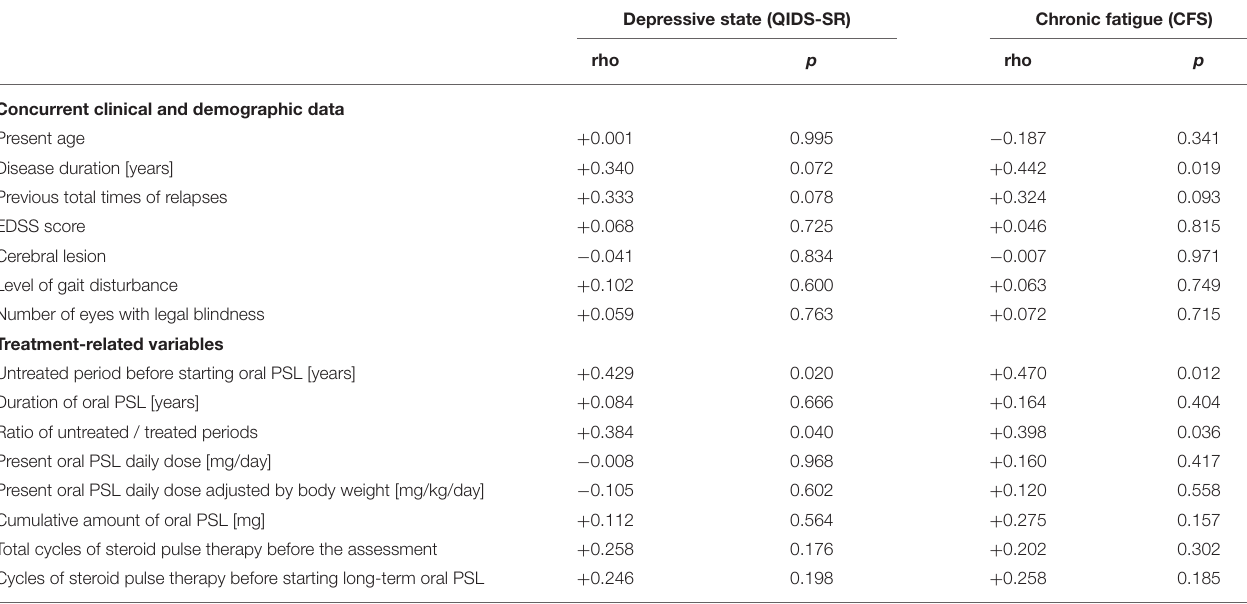
TABLE 3 | Correlation matrix among those without non-steroidal immunosuppressants ( n = 29).